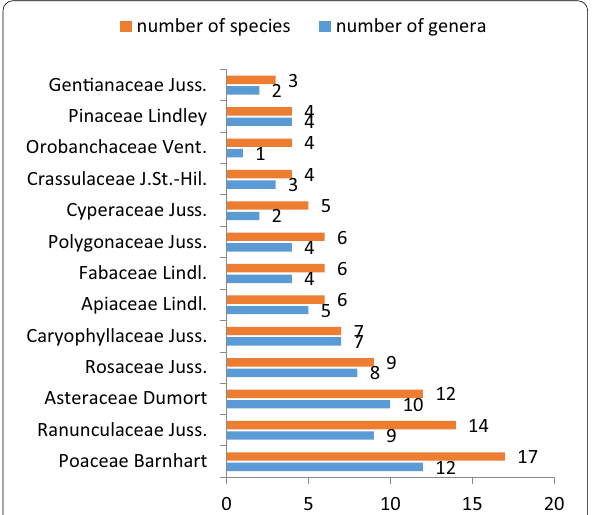
Fig. 6 Leading families with the number of genera and species within the composition of the R. rosea habitats